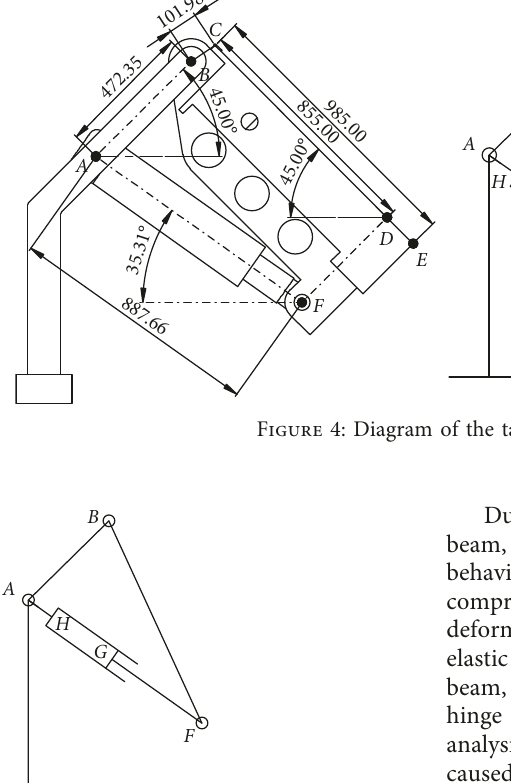
Figure 5: Kinematics diagram of the tail